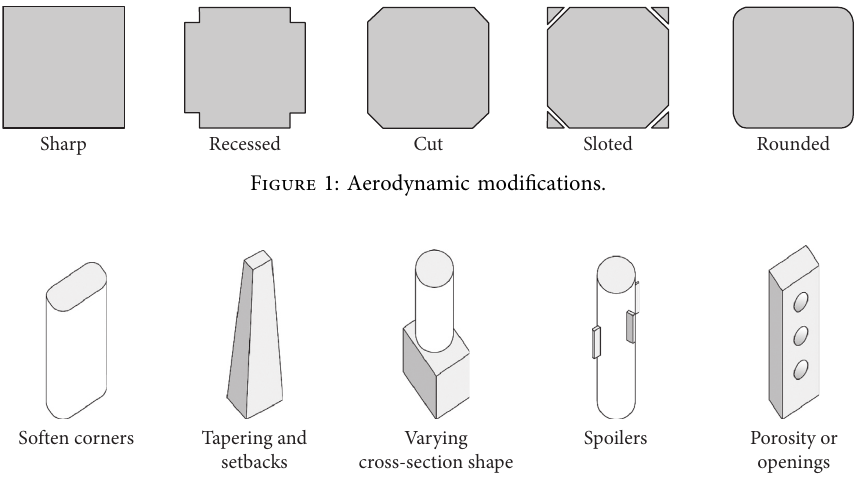
Figure 2: Aerodynamic